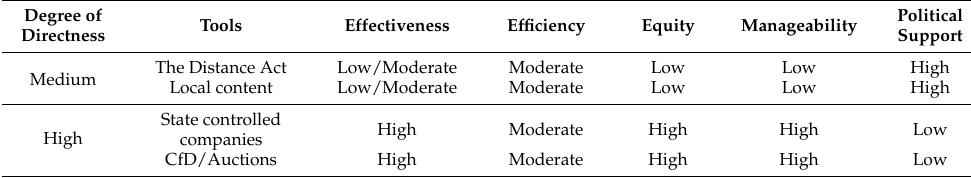
Table 5. Degree of directness.